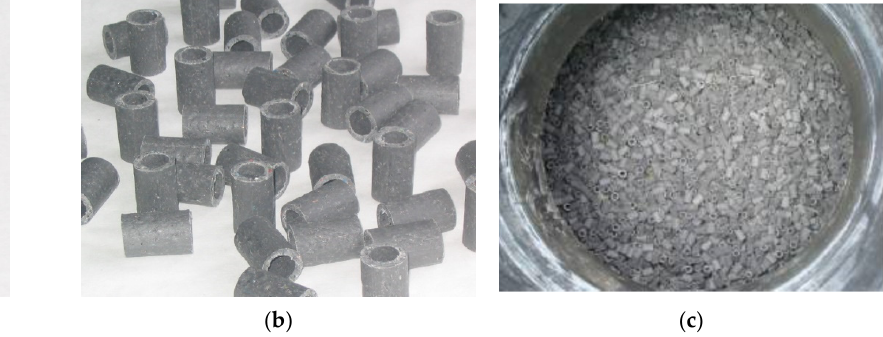
Figure 4. LCRF elements (( a ) a single LCRF piece with visible porosity; ( b ) extruded filling; ( c ) LCRF in the anaerobic reactor).